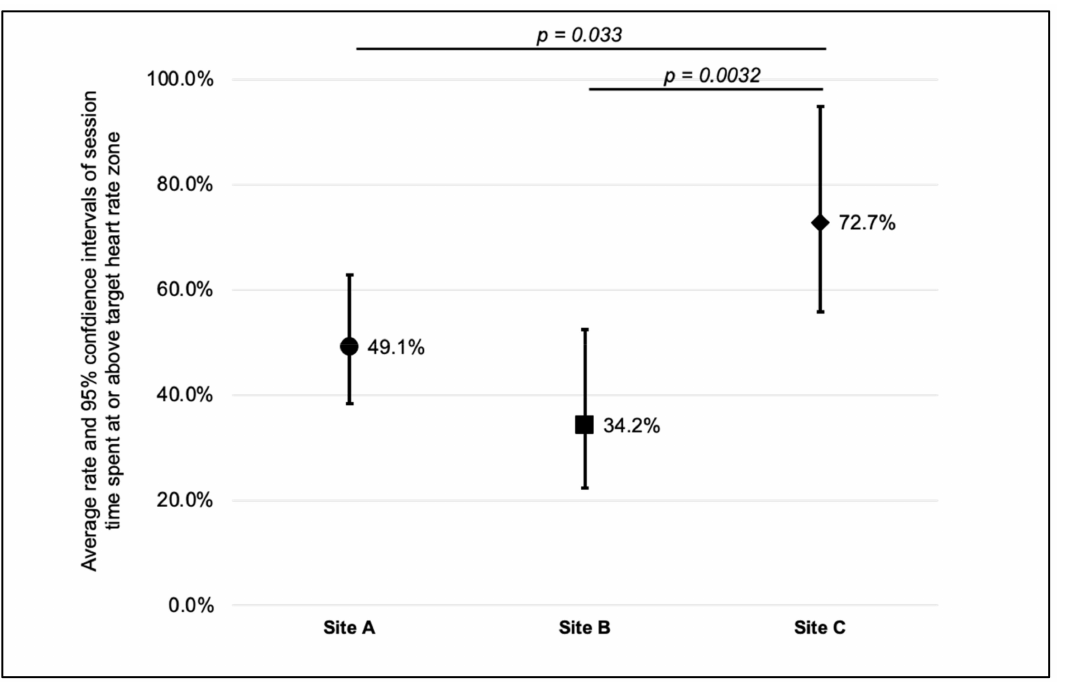
Figure 2. Average percentage and 95% confidence intervals of session time spent in or above participant target heart rate zone, by